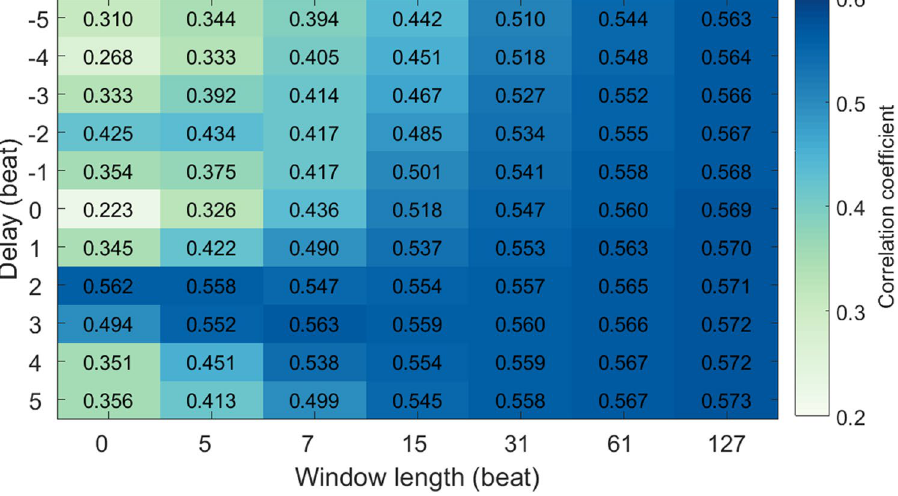
Figure 5. The correlation coefficients between RRI and PAT with different delays and different smoothness for all subjects in the natural state. The presented data are averaged over all subjects. Window length, the window length of the Savitzky-Golay filter (if 0, no smoothing). Delay, the delayed beats of RRI